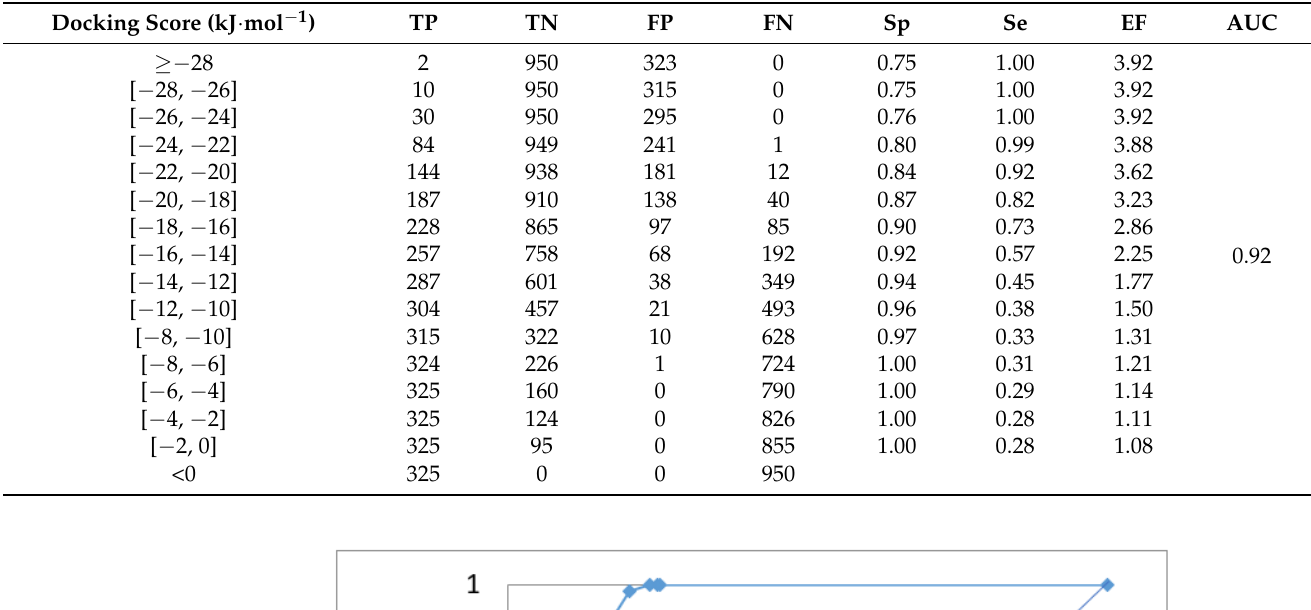
Table 7. Results docking and model evaluation based on the ROC.